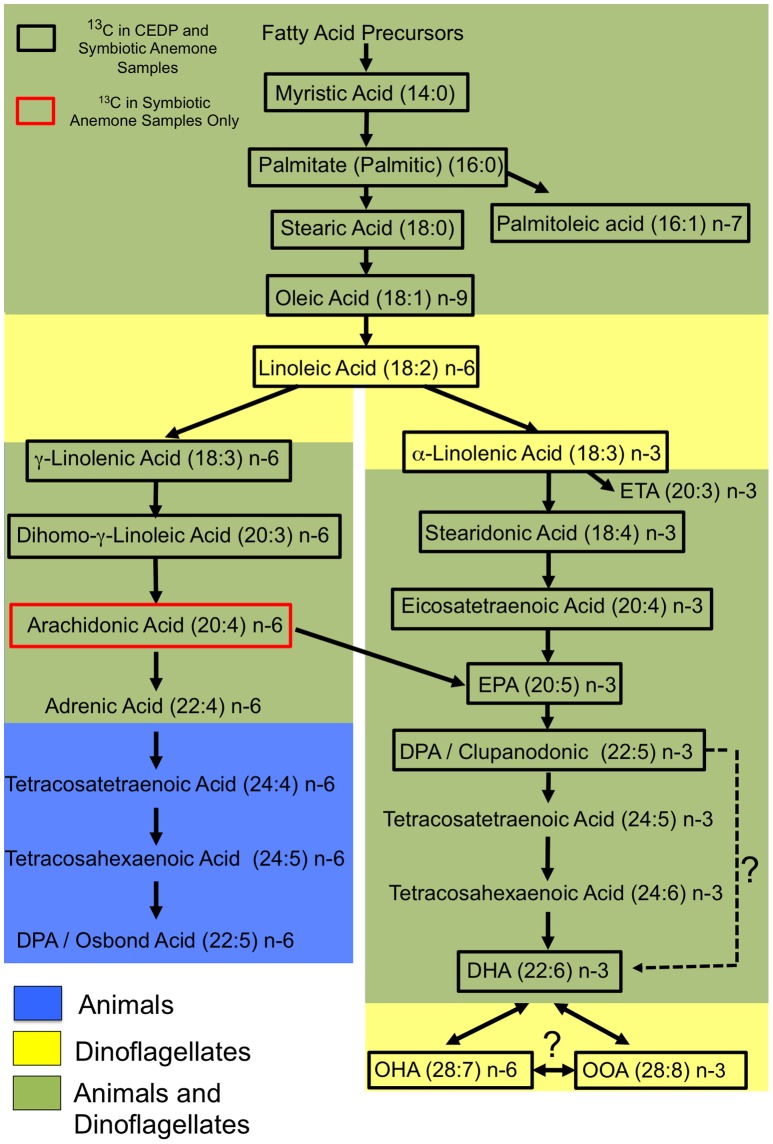
Schematic representation of the lipogenesis pathways utilizing DI13C (HCO3
−) as a carbon source (dash arrow  =  potentially active and ?  =  links by evidence of incorporation, but not previously described) [2].